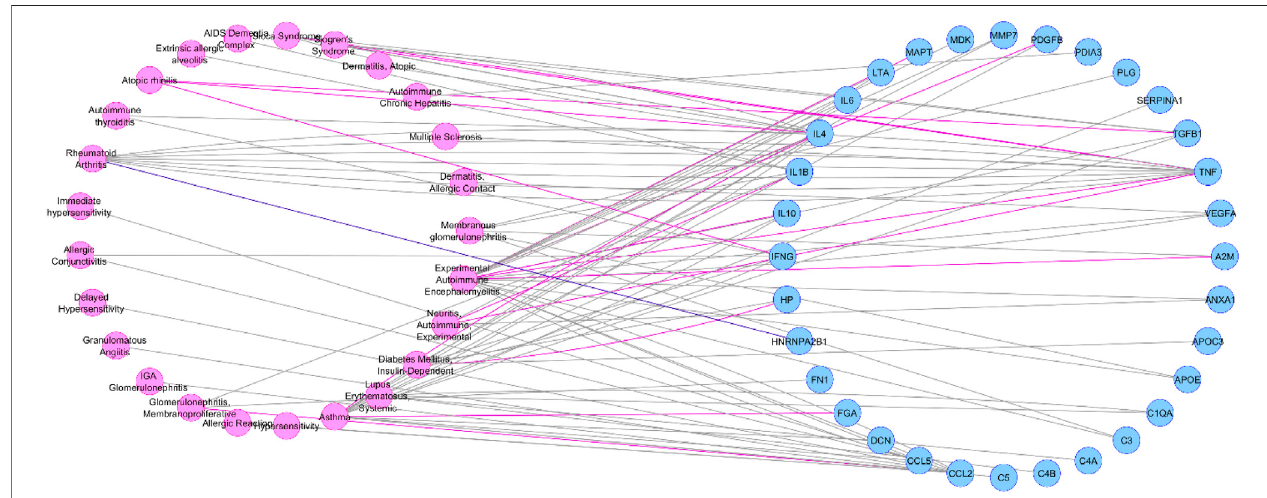
FIGURE 3 | Animal model diseasome network (AMDi) . AMDi form the two node sets of bipartite networks with two types of nodes: diseases (pink circle) and gene (blue circle). Disease node and gene node are connected if the gene is implicated in the